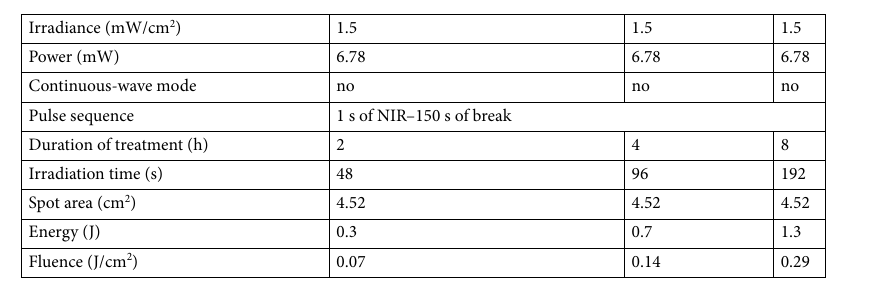
Table 2. Photobiomodulation parameters—time-dependent dosing of NIR.